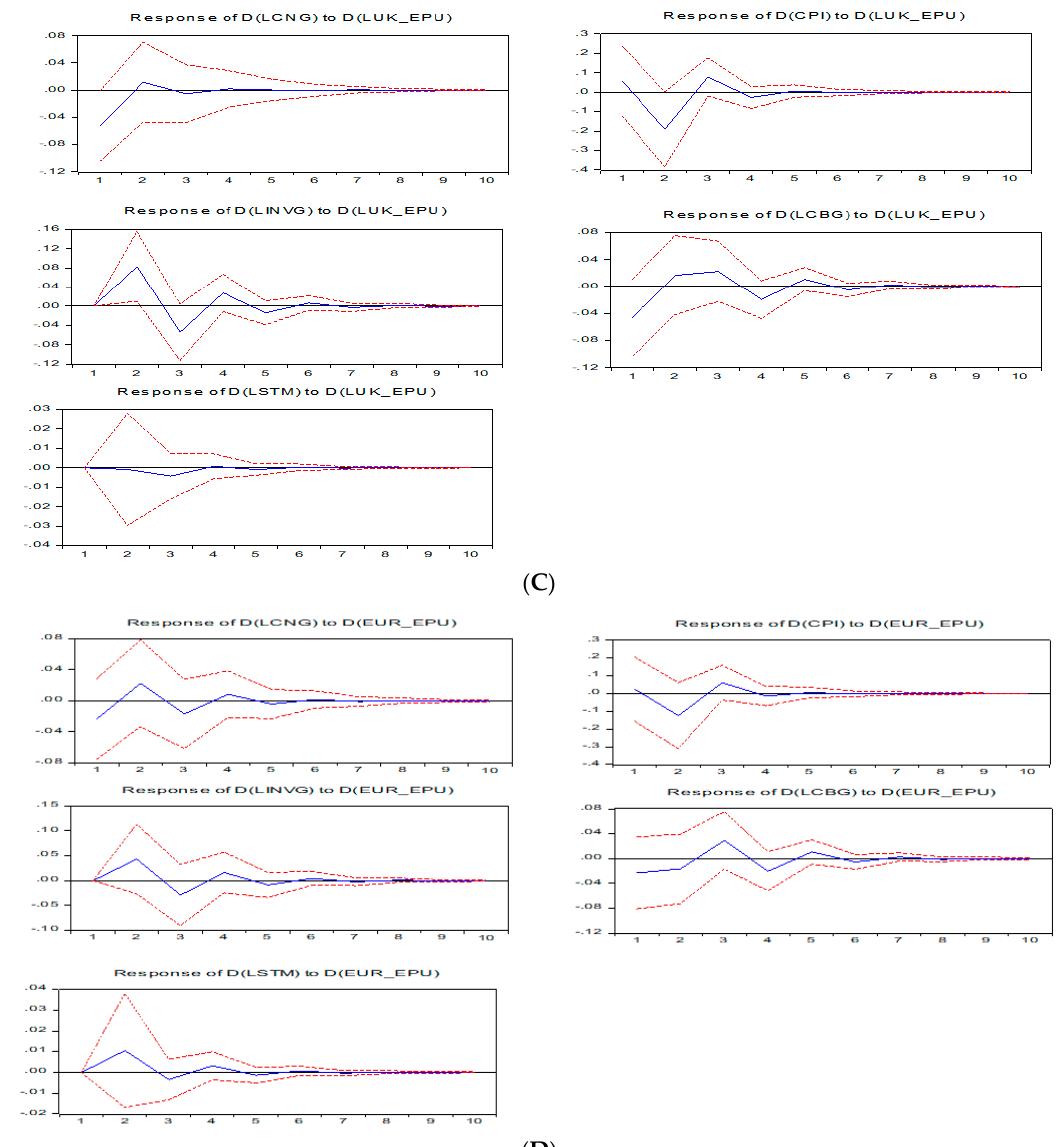
Figure 3. ( A ) Impact of Domestic EPU on China. Note: It shows the impulse response function of consumption, inflation, investment, credit growth and stock market to a Cholesky one standard deviation Domestic EPU context of China. Whereas, the two outer lines are Monte Carlo constructed 95% confidence interval. ( B ) Impact of US EPU on China. Note: It shows the impulse response function of consumption, inflation, investment, credit growth and stock market to a Cholesky one standard deviation foreign EPU i.e., USA in context of China. Whereas, the two outer lines are Monte Carlo constructed 95% confidence interval. ( C ) Impact of UK EPU on China. Note: It shows the impulse response function of consumption, inflation, investment, credit growth and stock market to a Cholesky one standard deviation foreign EPU i.e., UK in context of China. Whereas, the two outer lines are Monte Carlo constructed 95% confidence interval. ( D ) Impact of Europe EPU on China. Note: It shows the impulse response function of consumption, inflation, investment, credit growth and stock market to a Cholesky one standard deviation foreign EPU i.e., Europe in context of China. Whereas, the two outer lines are Monte Carlo constructed 95% confidence interval.